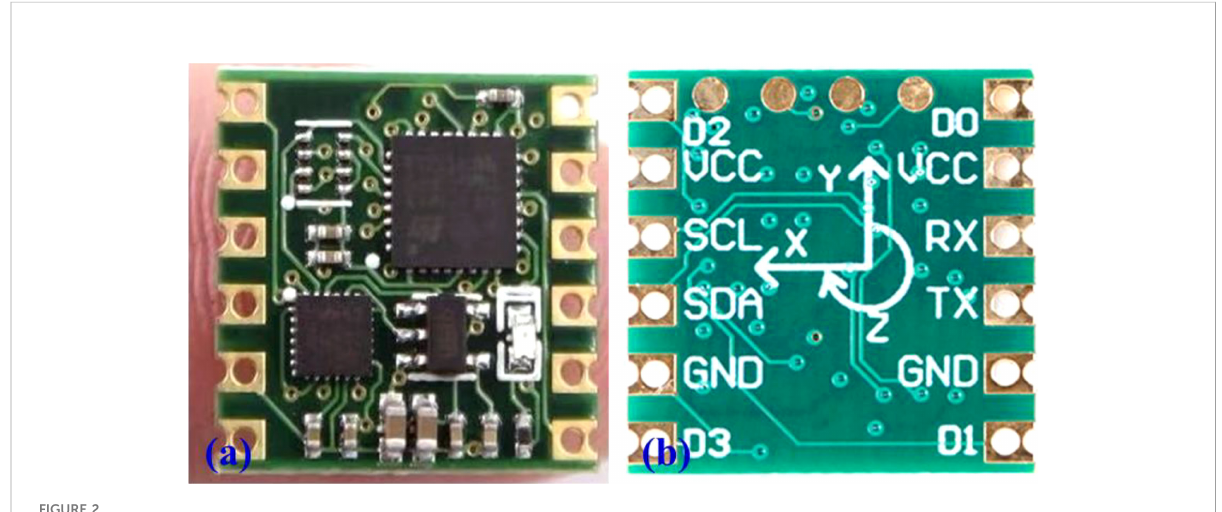
FIGURE 2 QZ901 IINM: (A) front side; (B) back side.